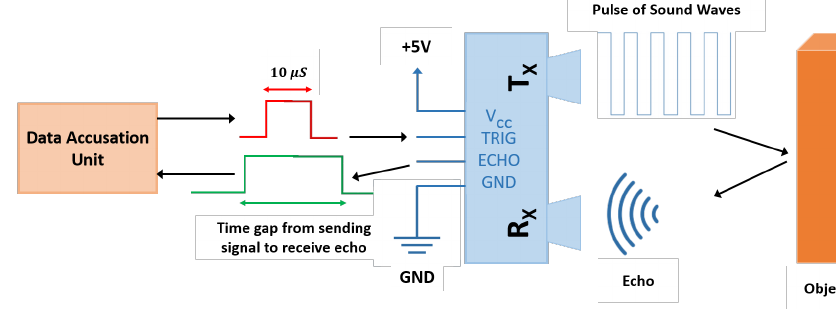
Figure 9. Ultrasonic principle [55].